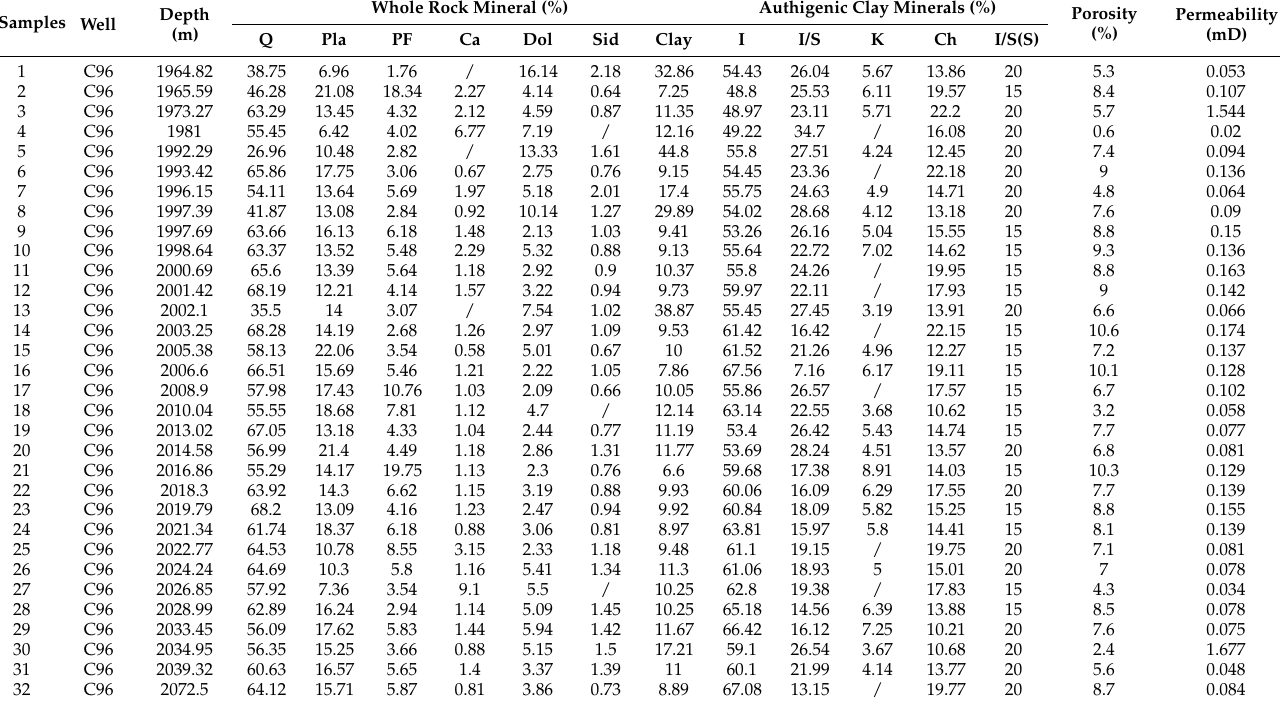
Table 1. Petrophysical characteristics and XRD analysis data of tight sandstones in well C96 of the Chang-7